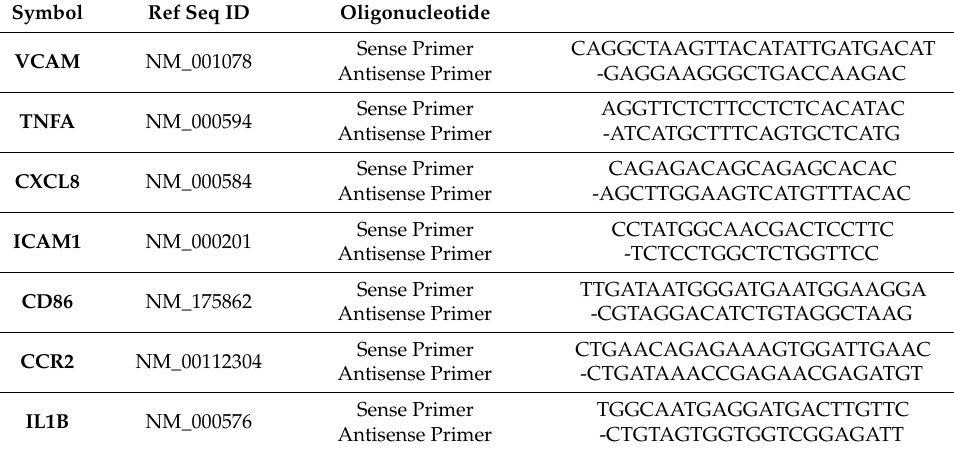
Table 1. Sequence of primers used in